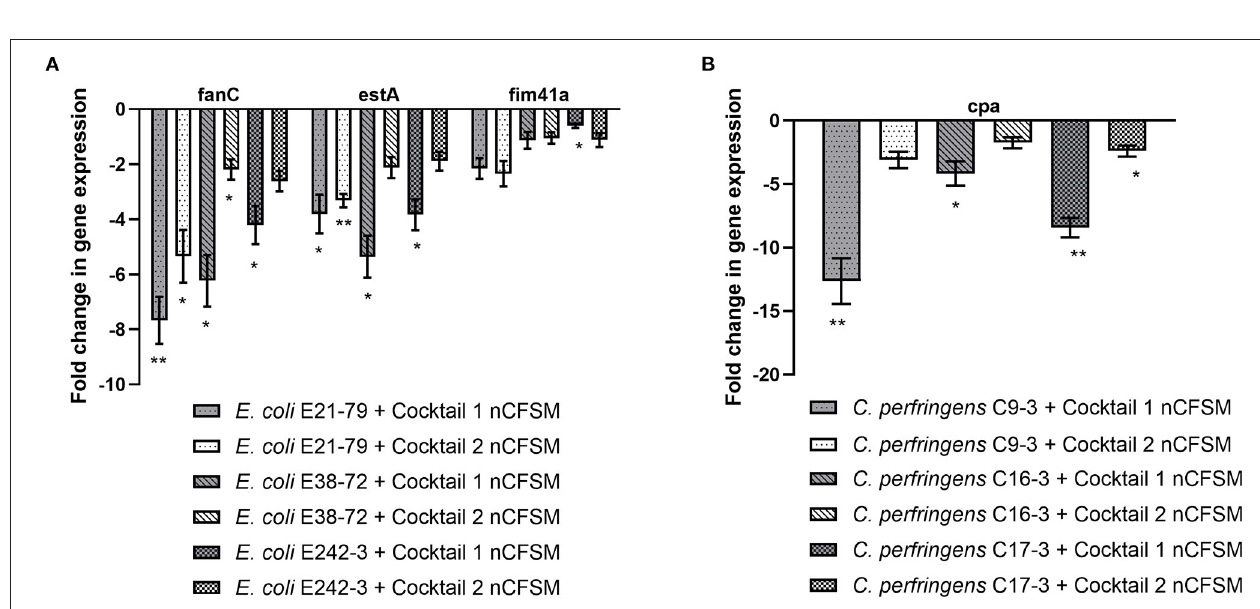
FIGURE 5 | Effect of nCFSM from (A) NU-TRISH ® By-Mild ( L. delbrueckii subsp . bulgaricus , S. thermophilus and B. lactis BL-15954, (B) COMBO4 ( L. delbrueckii subsp .bulgaricus and S. thermophilus ) and (C) L. helveticus CNRZ32 on virulence gene expression in 3 S. Dublin strains. The expression data were normalized to validated reference gene gapA and presented as fold change of expression levels in nCFSM relative to a control (non-fermented milk). Three independent replicates including two technical replicates each were performed. The data shown represents the mean and the error bars represent standard deviations. The stars indicate statistical significance at different levels: * P ≤ 0.05, ** P ≤ 0.01.